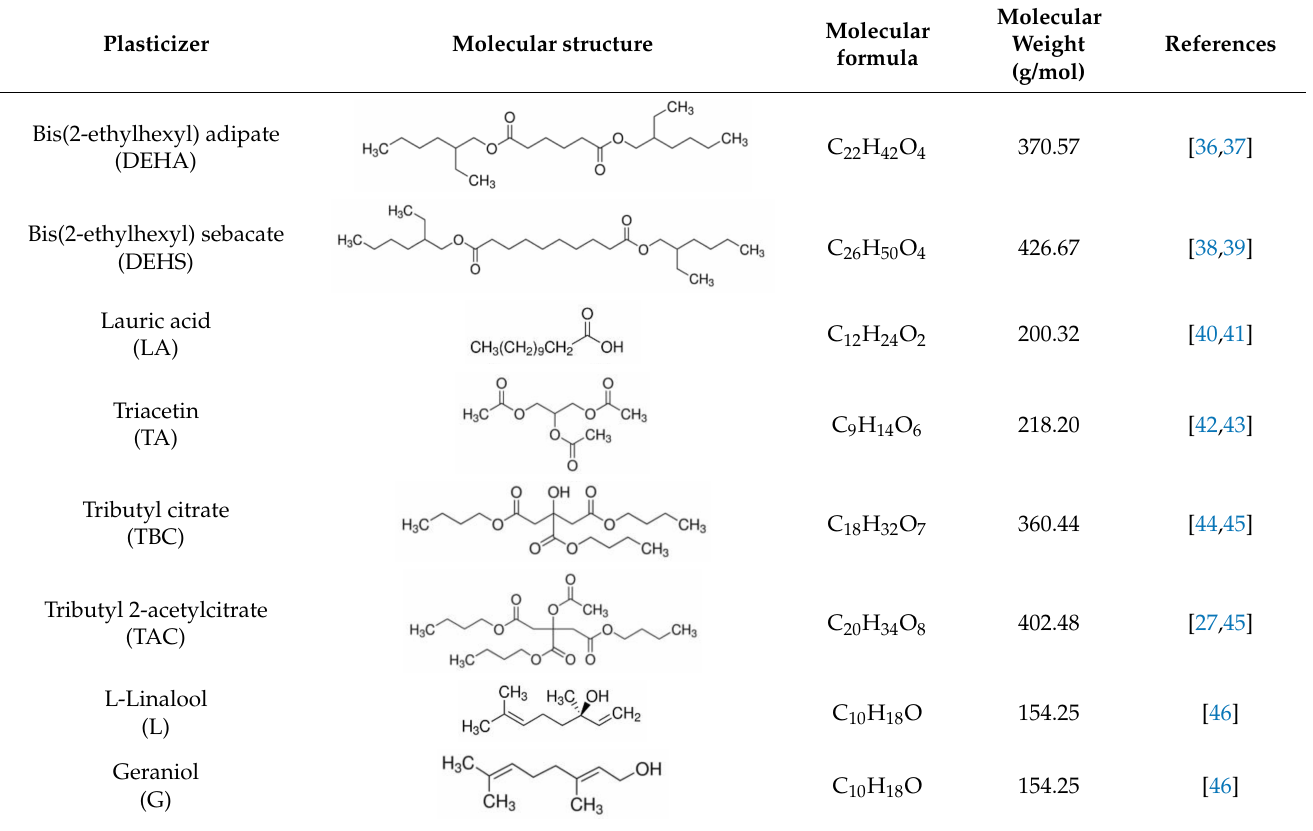
Table 1. Molecular properties and applied references of plasticizers used in this